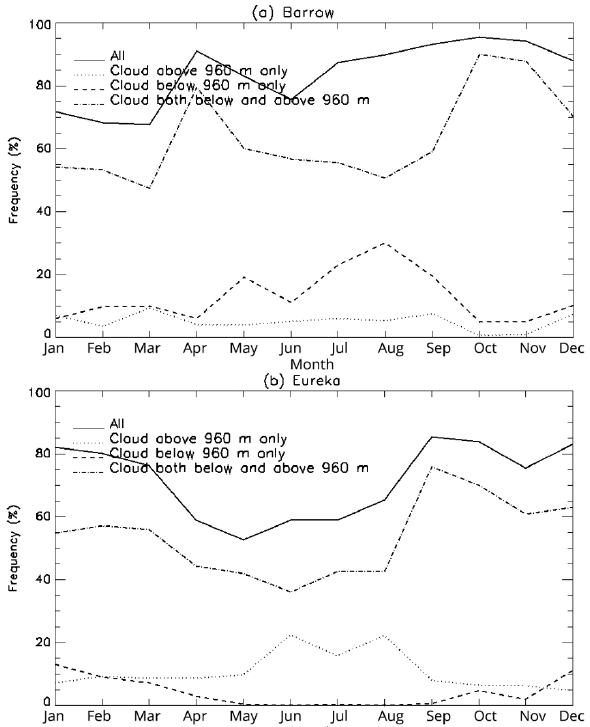
Figure 5. Monthly mean cloud fraction from surface observations, 2B-GEOPROF-lidar, CALIPSO 1km, CALIPSO 5km, and 2B- GEOPROF at (a) Barrow (top) and (b) Eureka (bottom) for 2006– 2010.